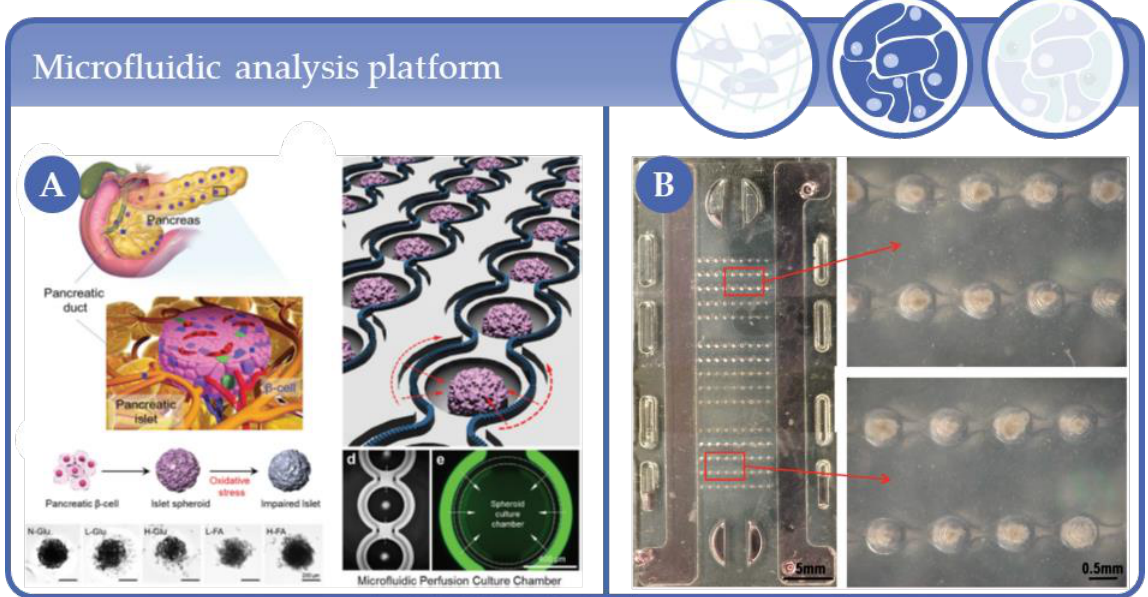
Figure 15. ( A ) Microfluidic analysis platform (MAP) for the 3D cultivation of pancreatic islets. A total of 110 islets can be loaded into one platform. Reprinted from [130] with permission of John Wiley and Sons. ( B ) Left: MBR seeded with embryoid bodies. Right: Magnification of individual microwells. Republished with permission of the Royal Society of Chemistry from [131]; permission conveyed through Copyright Clearance Center, Inc.